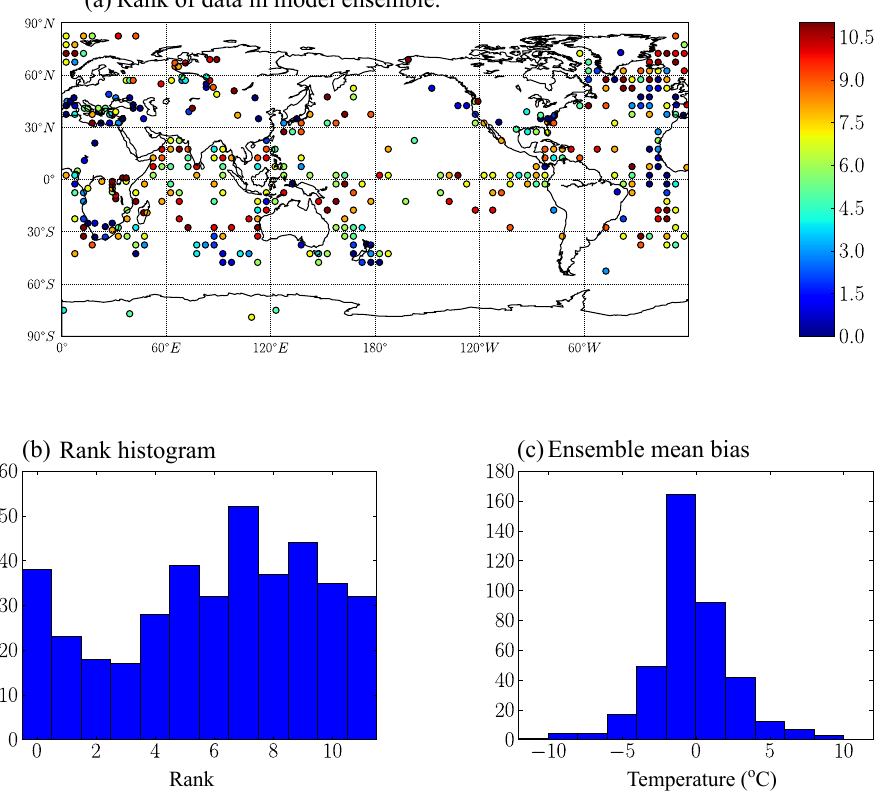
Fig. 3. (a) The rank of the data in the 11 member LGM ensemble. (b) Rank histogram of the ranks in plot (a) . (c) The histogram of the difference between the ensemble mean and the data for each data point in plot (a) . A low rank indicates that the climate change is greater in the models than the data.